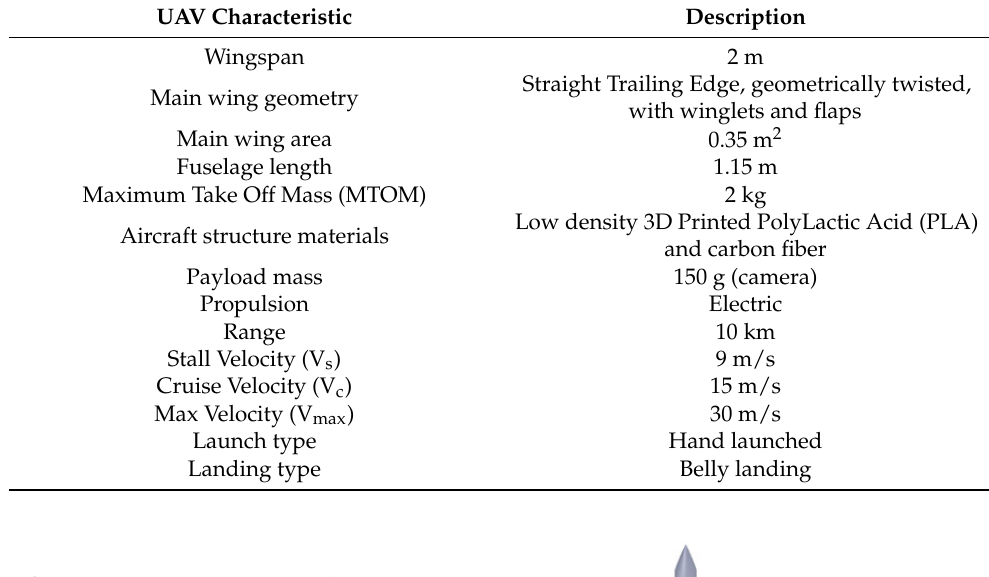
Table 1. Euclid SUAV characteristics.